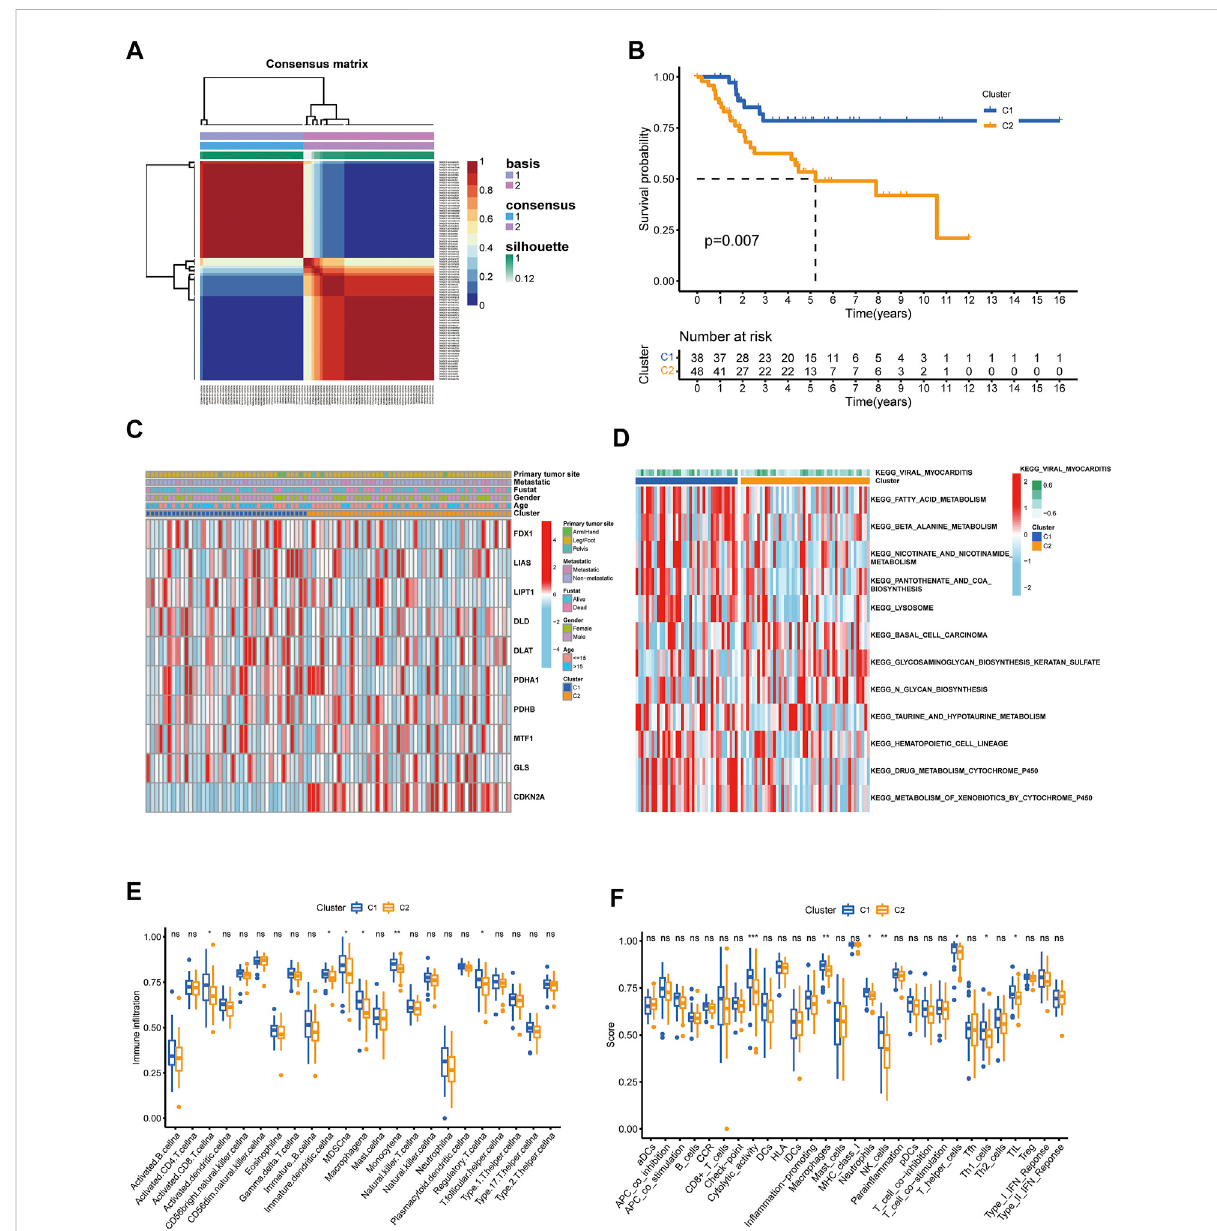
FIGURE 3 Identi fi cation of cuproptosis subtypes in OS. (A) t-SNE of the mRNA expression pro fi les of CUGs from the OS samples in the TARGET dataset con fi rmedthe twoclusters:C1and C2. (B) Kaplan-Meier curves for the twomolecularpatterns ofOS patients. (C) Heatmap depicted thecorrelation between the subtypes and different clinicopathological characteristics. (D) GSVA enrichment analysis of biological pathways between the two distinct subtypes. Boxplots showed abundance of 23 in fi ltrating immune cell types (E) and differences in immune scores (F) in the two cuproptosis subtypes. ( p < 0.05 *; p < 0.01 **; p < 0.001